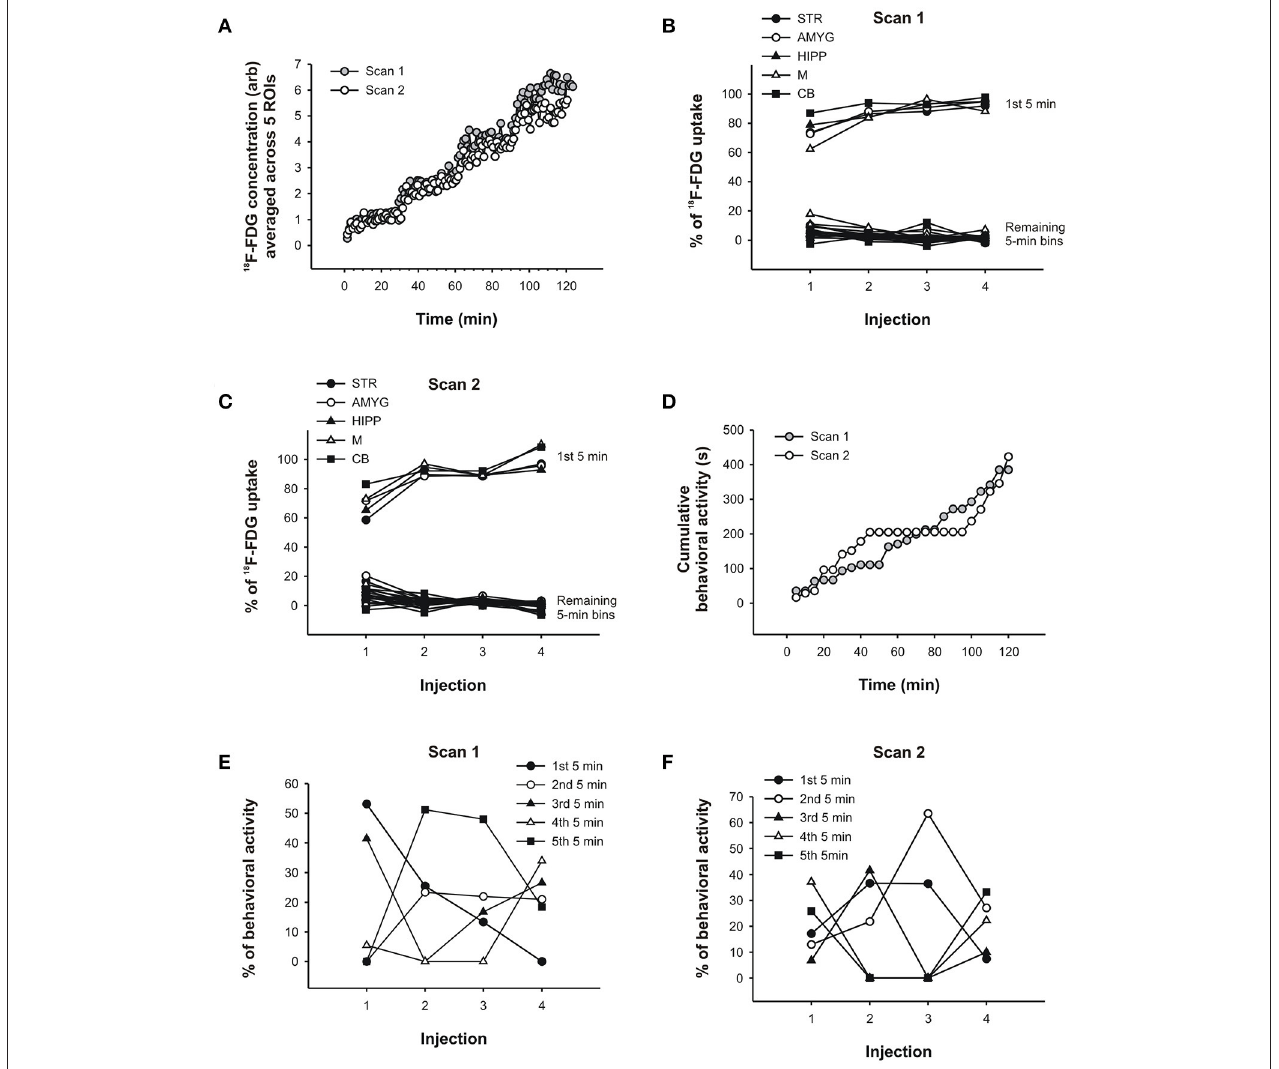
FIGURE 6 | PET data and behavioral analysis for the rat. (A) Time-activity curves of scan 1 and scan 2 averaged across 5 ROIs, respectively. 18 F-FDG uptake in (B) scan 1 and (C) scan 2 across successive 5min time bins in % of the total uptake during 25min following each injection of 18 F-FDG. Most of the uptake occurred within the first 5min following each injection. These results were similar for all 5 brain regions examined. (D) Behavioral activity (s) was summed into 5min time bins and cumulated, that is, each successive 5min bin was added to the previous sum. In this way, a slope in the behavioral response curve indicates that the rat displayed activity, whereas flat regions indicate the absence of activity. The prolonged absence of activity starting at 45min in scan 2 coincides with the injection of morphine. Similar to the PET data analyses in (B,C) , the behavioral activity of the rat in scan 1 (E) and scan 2 (F) was analyzed across successive 5min time bins in % of the total activity during 25min following each injection of 18 F-FDG. The behavior was distributed across time in fairly unpredictable ways. STR, striatum; AMYG, amygdala; HIPP, hippocampus; M, motor cortex; CB, cerebellum.